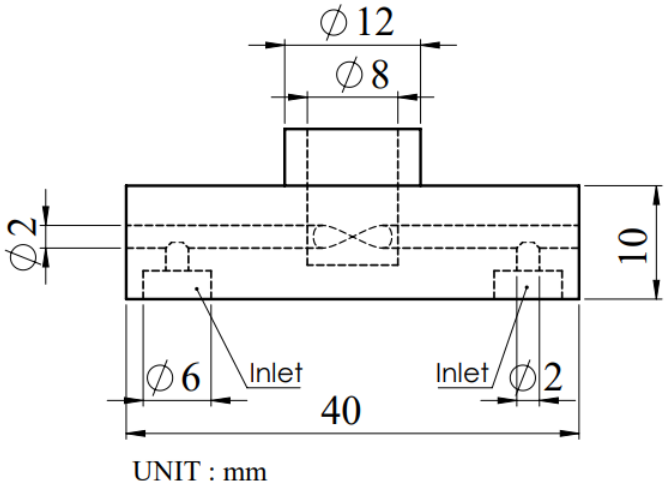
Figure 3. Vertical vortex combustor dimensions .